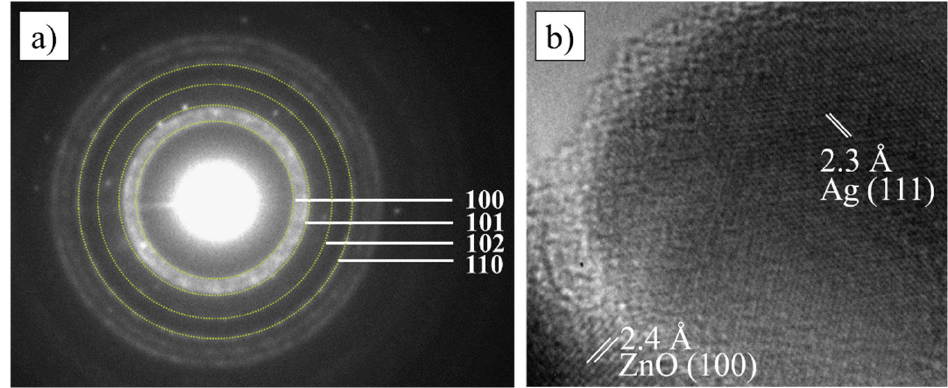
Figure 3. ( a ) SAED and ( b ) HR ‐ TEM of ZnO ‐ Ag nanoparticles at a Ag content of 1 wt%.